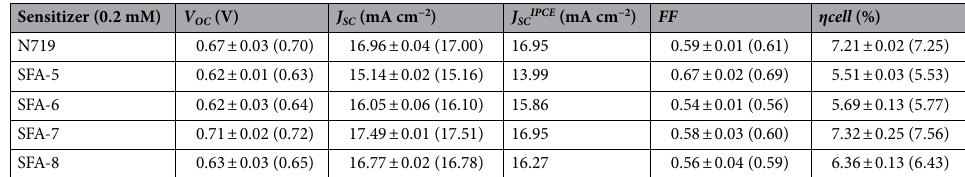
Sensitizer (0.2 mM) V OC